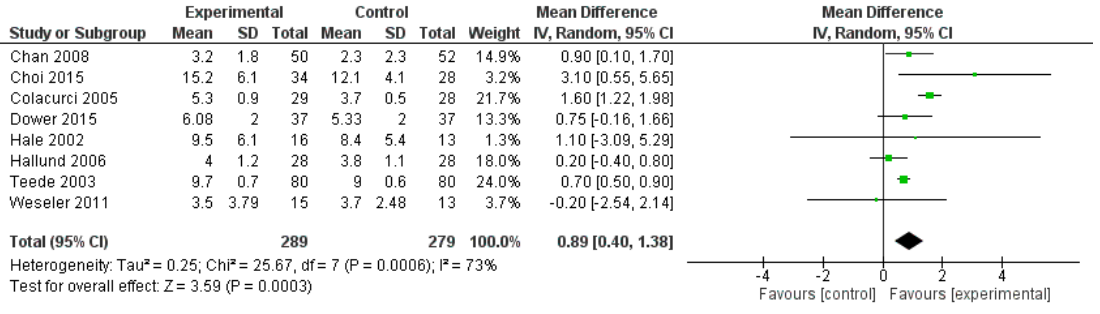
Figure 6. Pooled analysis of association between polyphenol intake and flow mediated dilation (FMD).